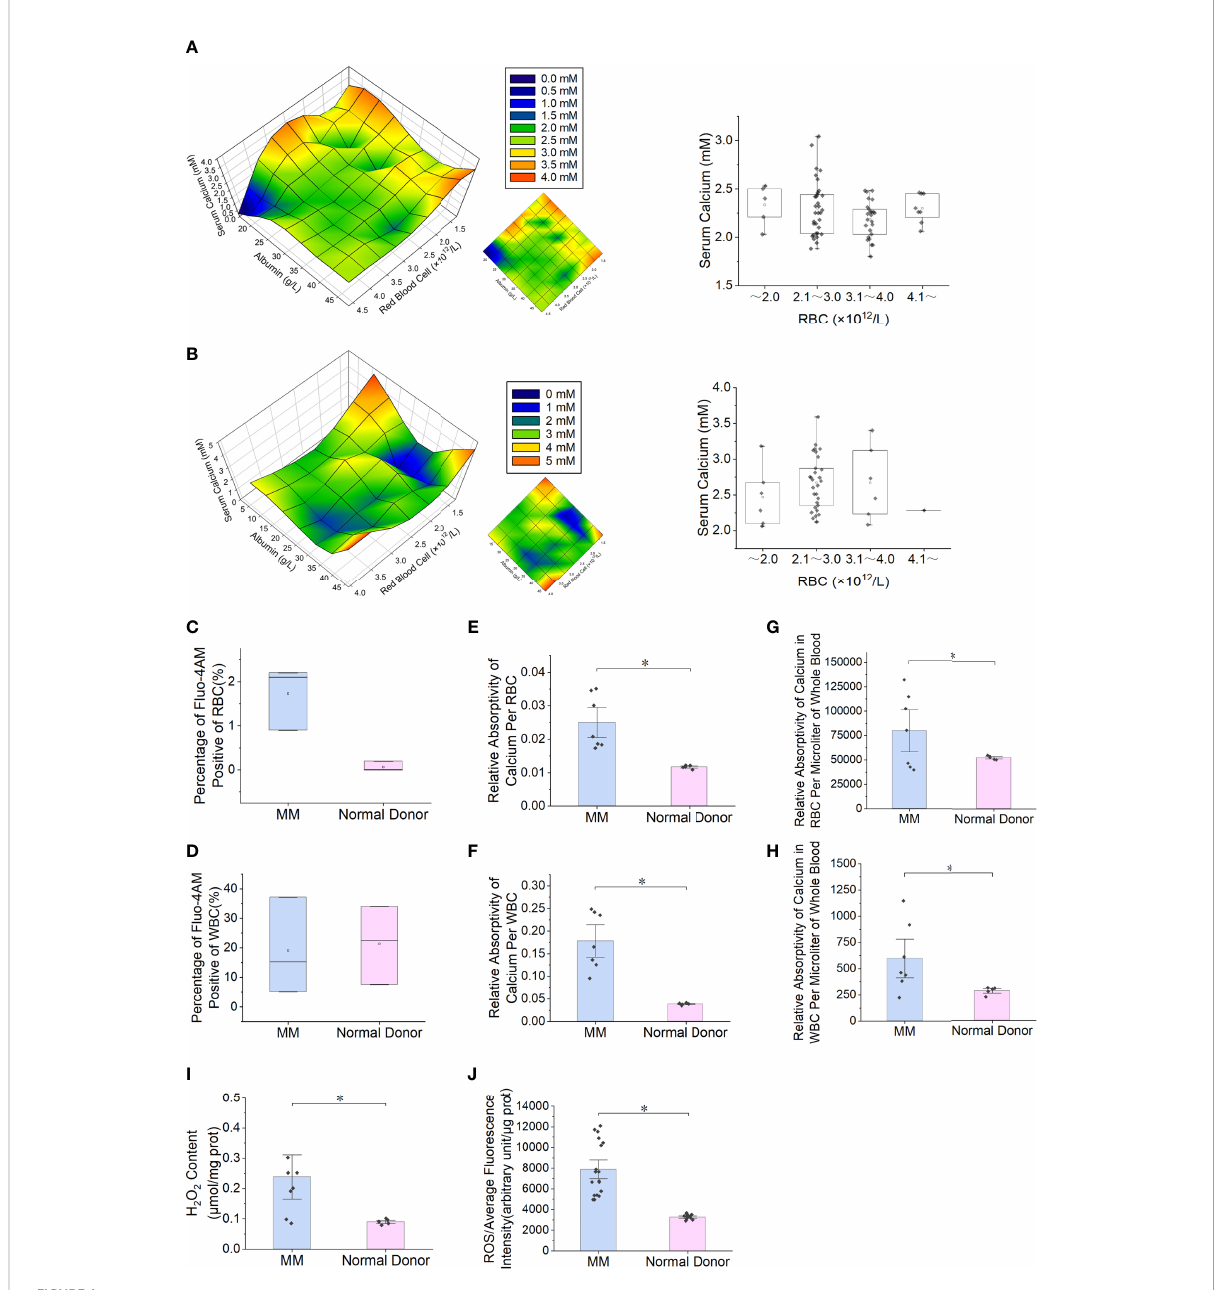
FIGURE 1 Serum calcium and intracellular calcium levels and RBC oxidative stress in patients with multiple myeloma. (A) The patients' serum albumin concentration, serum calcium concentration and the number of RBCs per unit volume of blood are used for three-dimensional composition. In MM patients with normal renal function (number = 71), the serum calcium content increases as the number of RBCs per unit volume decreases. The box chart on the right shows that a high serum calcium level occurs when the number of RBCs is less than 2.0×1012·L-1. When the serum albumin concentration is < 25.0 g·L-1, serum calcium level appears earlier when the number of RBCs is decreased. (B) In MM patients with renal insuf fi ciency (number = 42), the analysis results show that the serum calcium level does not increase with the decrease in RBC number. (C, D) Flow cytometry (FCM) was used to measure Fluo-4 AM-labeled free calcium ions in RBCs or WBCs. (E, F) The total calcium content of single RBCs or WBCs measured by fl ame atomic absorption spectroscopy (F-AAS) was signi fi cantly higher in multiple myeloma than in the normal control group (P = 5.8E-03). (G, H) The total calcium content of all RBCs or WBCs per microliter of blood measured by F-ASS was signi fi cantly higher in multiple myeloma than in the normal control group (P = 4.4E-02). (I, J) Detection of ROS and H2O2 content in RBCs of MM patients and normal controls (PROS = 5.3E-6, PH2O2 = 1.1E-2). (Error bars represent the mean ± SEM, *P <